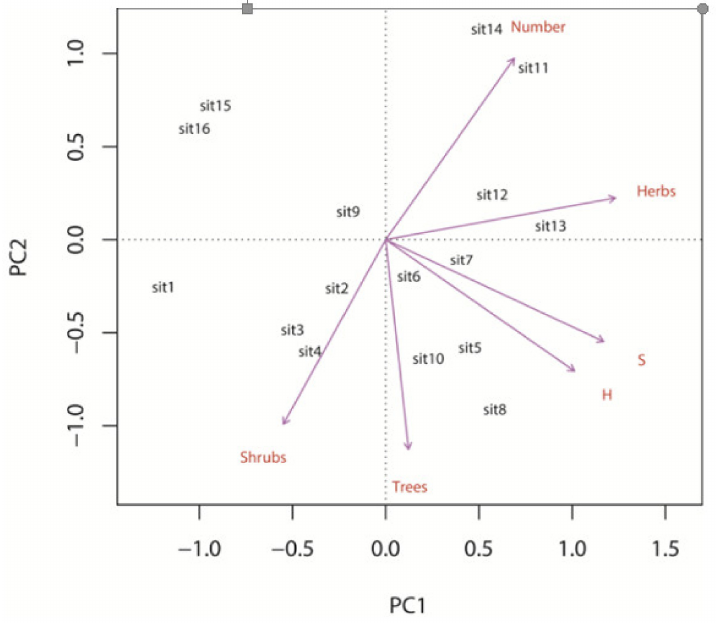
Figure 3. PCA ordination showing the characteristics of altitudinal distribution of plants in the central Taihang Mountain